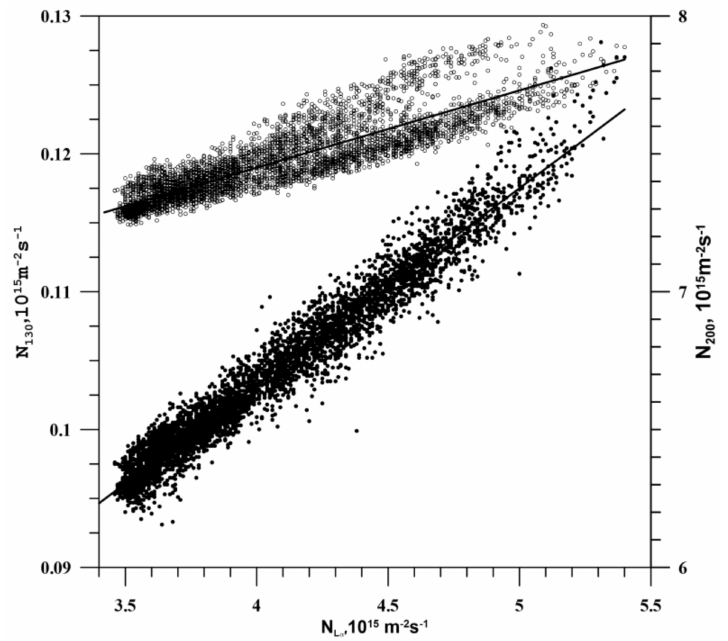
Figure 4. Dependence of photon fluxes in the interval 130–131 nm (dots) and 200–201 nm (circles) on the flux in the Lyman-alpha